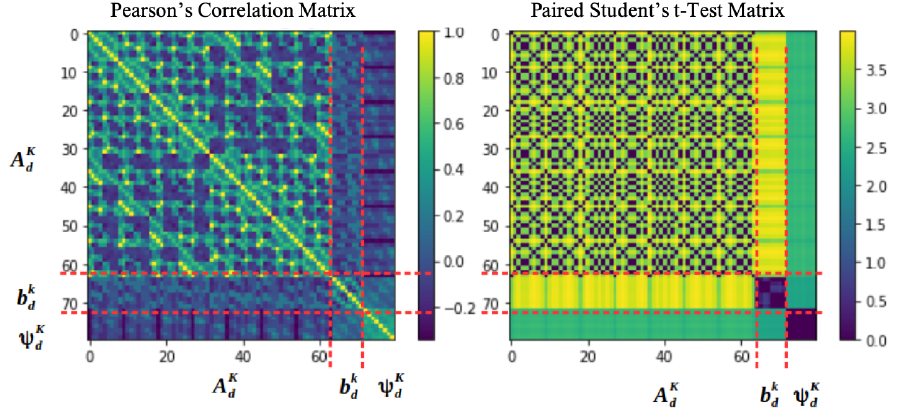
Figure 1: Pearson correlation matrix obtained for a set of 10 5 random one-cell DFEM